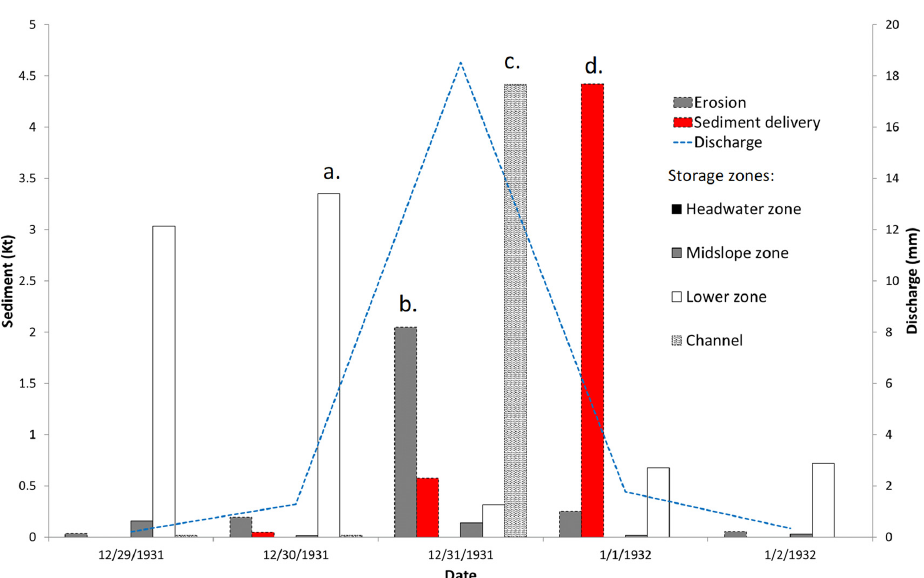
Figure 8. The model outputs for a four-day event in the Cranemere catchment indicating the cascade of sediment delivery through sediment stores. Stored sediment in the lower zone ( a ) and eroded sediment during the discharge peak ( b ) moves to the lower zone ( c ) and finally leaves the catchment as sediment yield ( d ).